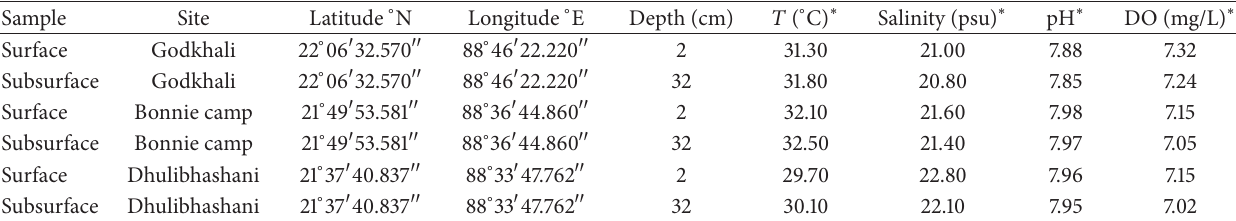
Table 1: Environmental parameters of sampling sites analyzed in this study.